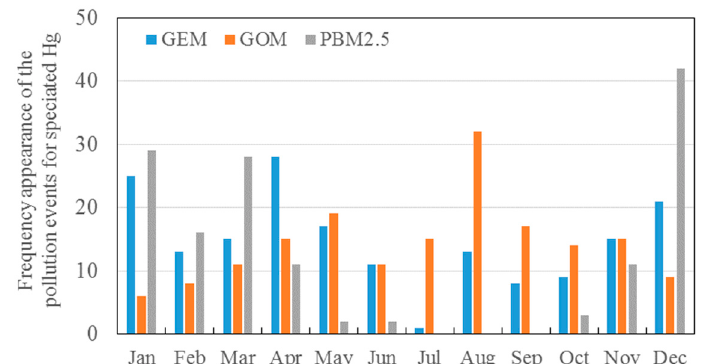
Figure 4. Seasonal variations in the frequency of the pollution events of GEM, GOM, and PBM 2.5 . The pollution events are defined as their values above the mean value plus 3× SD.